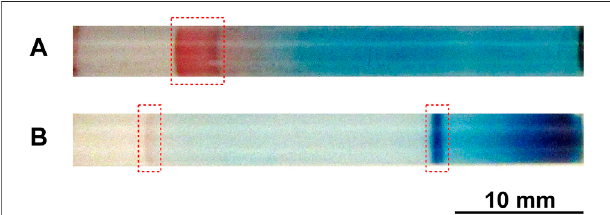
FIGURE 8 | (A) Typical precipitation pattern (formed at 25 ° C under an applied voltage of 2 V for 50 h) after removing unreacted ions and soluble compounds from the Cu – Fe PBA system. (B) Typical precipitation pattern (formed at 25 ° C under an applied voltage of 2 V for 20 h) after removing unreacted ions and soluble compounds from the PB system. The initial [Fe III (CN) 6 ] 3 ‒ concentration and the initial agarose density were 0.050 M and 2.0 mass%, respectively. The regions in which a precipitation band was formed are indicated by red squares. A scale bar is provided at the bottom of the